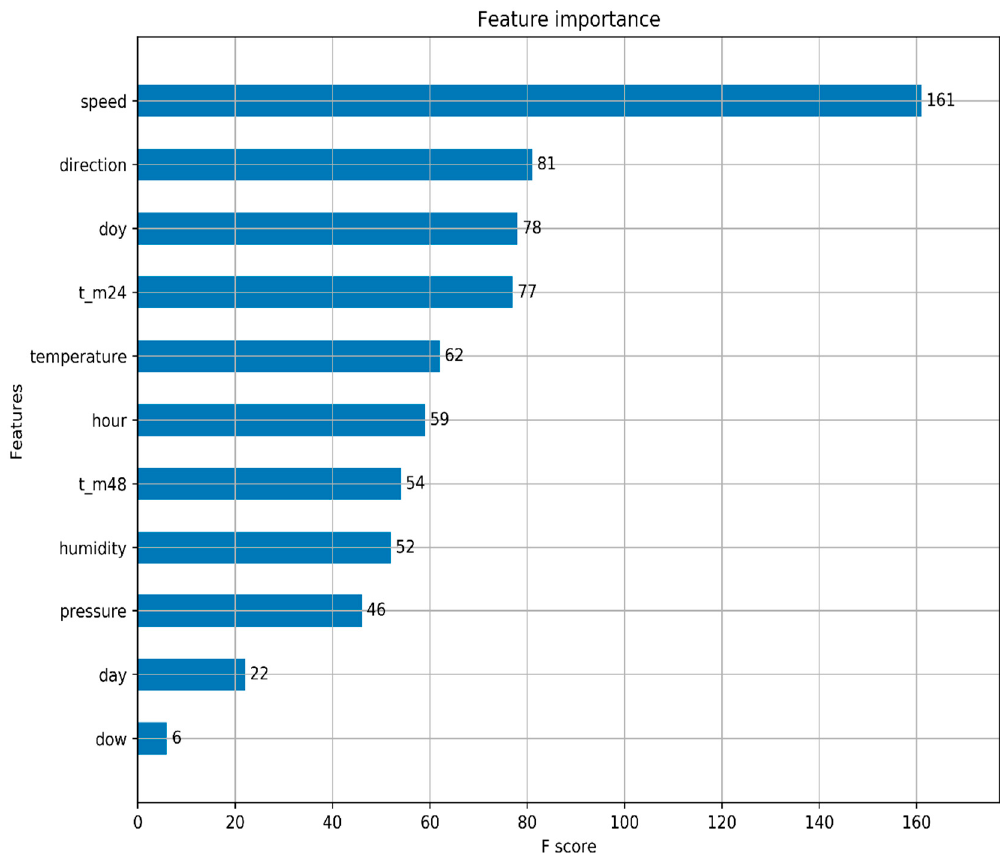
Figure 2. The value of importance for each feature.